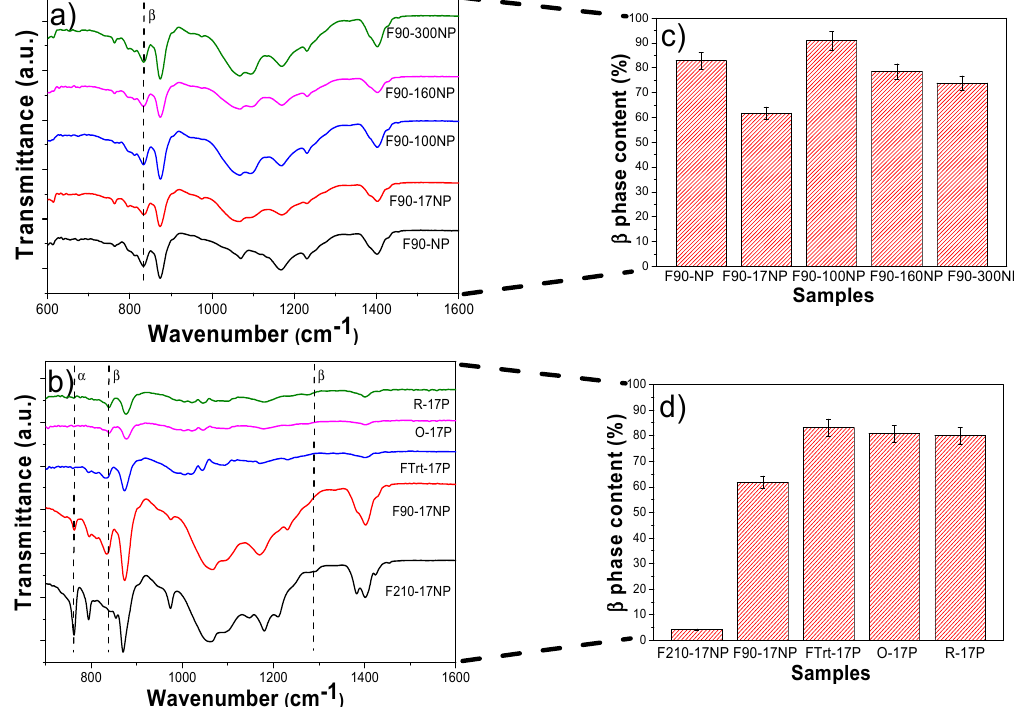
Figure 6. FTIR spectra of ( a ) neat PVDF and SiNPs/PVDF nanocomposites with silica nanoparticles of different diameters processed at 90 °C and ( b ) different morphologies of SiNPs nanocomposites